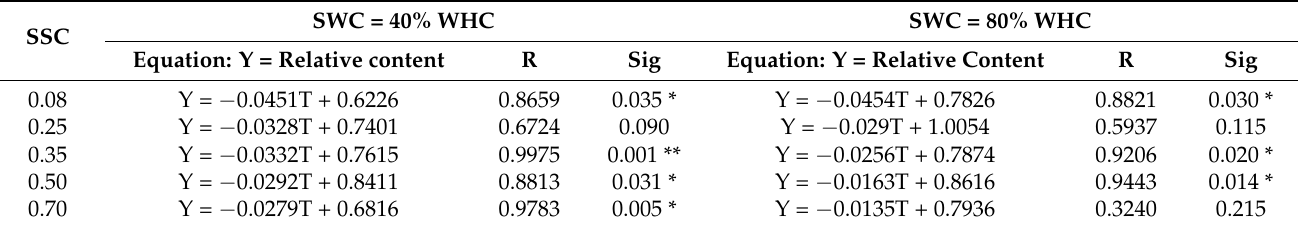
Figure 7. Relationship between relative NH 4+ -N content and freezing temperature under soil water content treatments (( a ) 40% water holding capacity (WHC) vs. ( b ) 80% WHC), and ( c ) the relation- ship between soil salt content (SSC) and the absolute values of their fitting line slopes. Table 5. Fitting lines of relative NH 4+ -N content and freezing temperature (SWC: soil water content; WHC: water holding capacity; SSC: soil salt content).